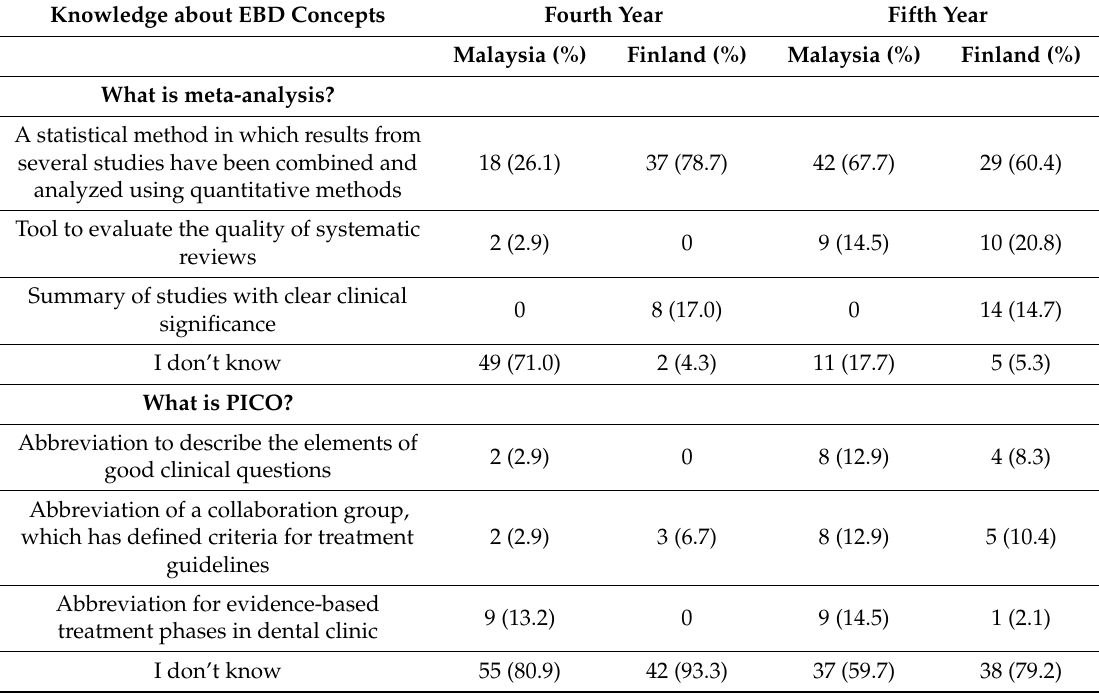
Table 4. The frequency and percentage distributions of dental students’ knowledge of EBD concepts among fourth- and fifth-year students from Malaysia ( n = 131) and Finland ( n =